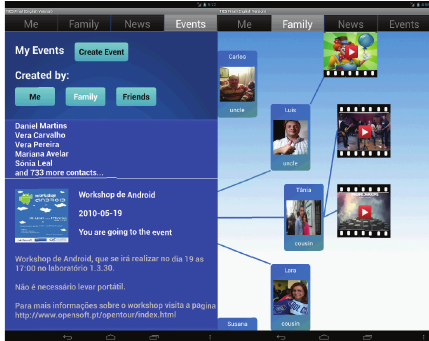
Figure 1: Prototype’s support for event management (left) and the family graph presentation